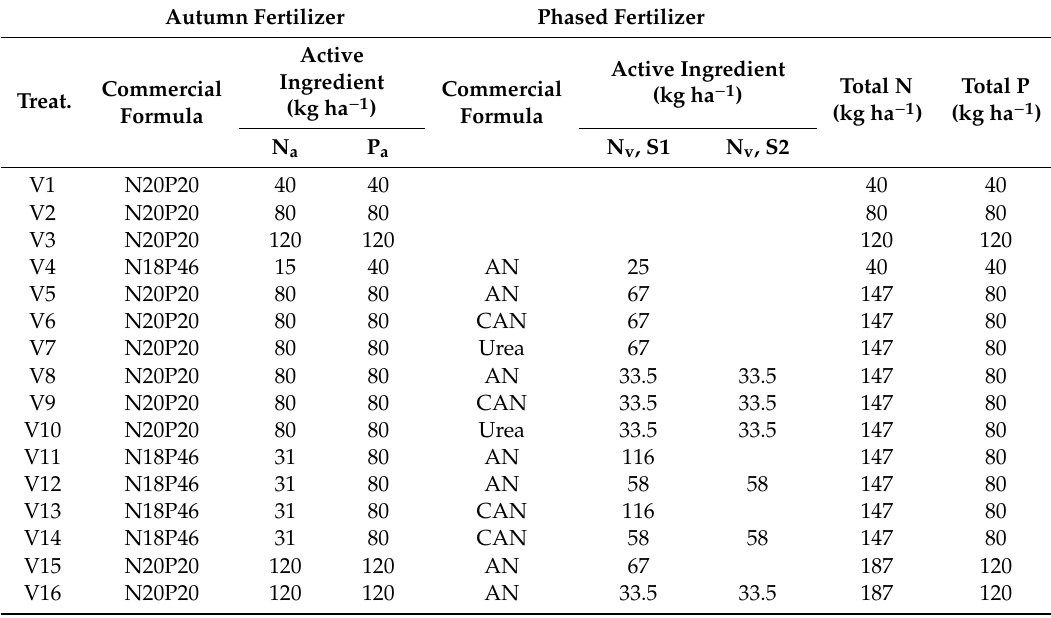
Table 1. Experimental design: Type, dose, and phase of fertilizer application. Autumn Fertilizer Phased